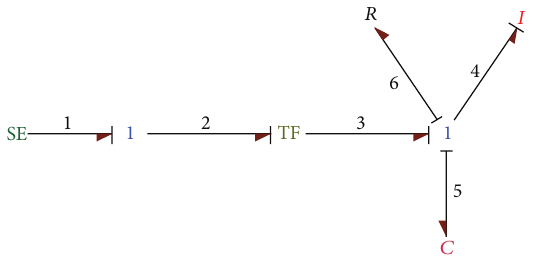
Figure 2: Bondgraph control valve